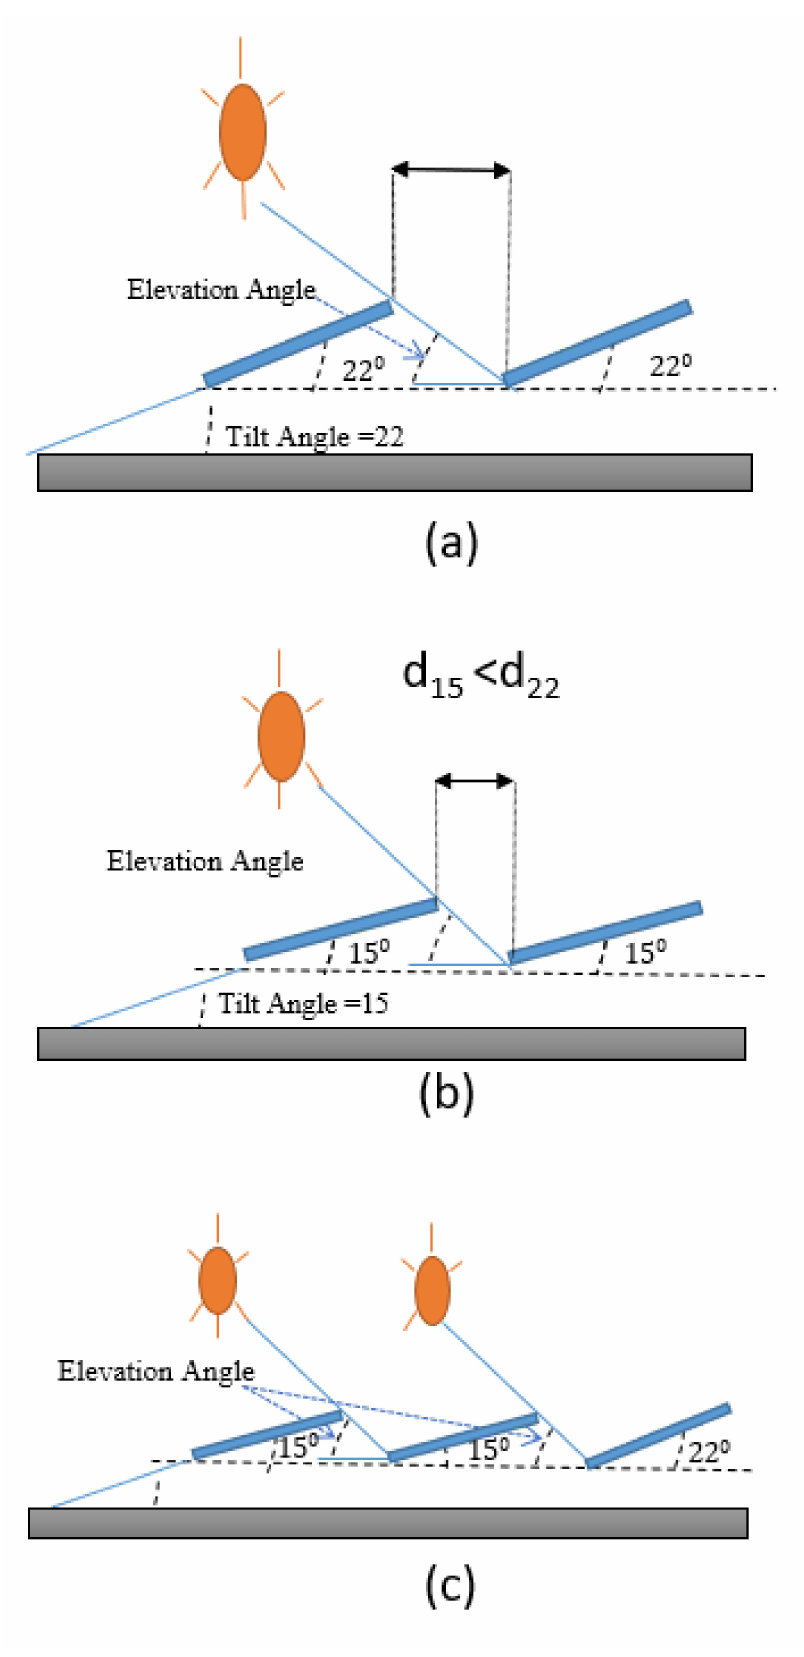
Figure 7. Relationship between elevation angle and spacing between rows: ( a ) Scenario 1, ( b ) Scenario 2, ( c ) Scenario